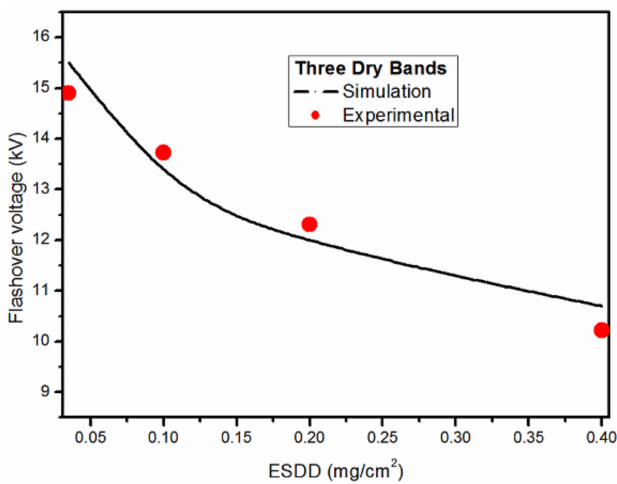
Figure 22. Flashover voltage for three dry bands model at different values of